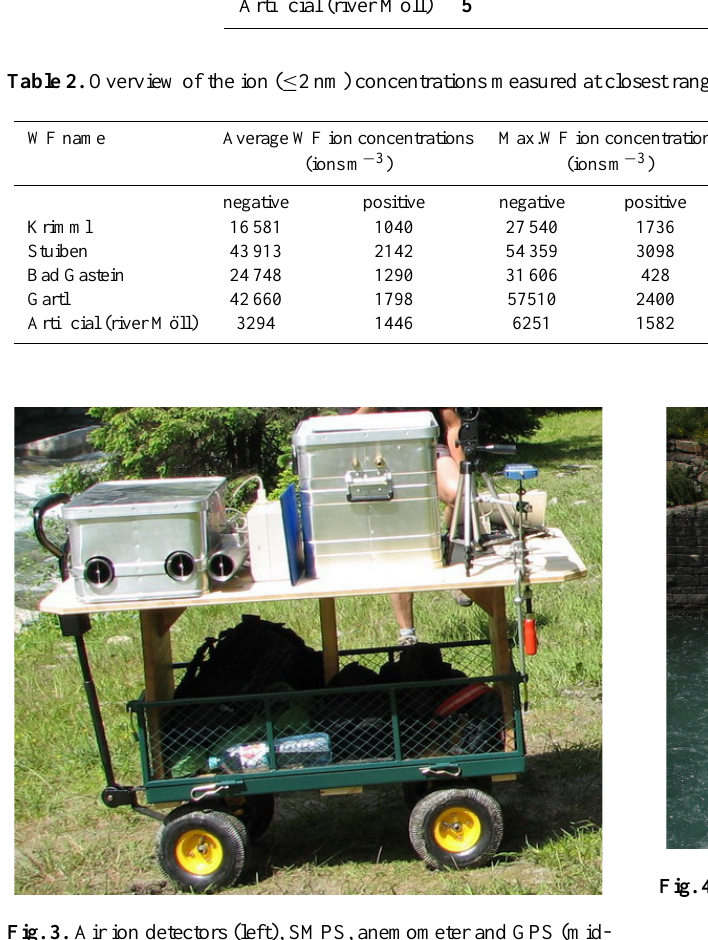
Fig. 3. Air ion detectors (left), SMPS, anemometer and GPS (mid- dle) and field strength meter (right).